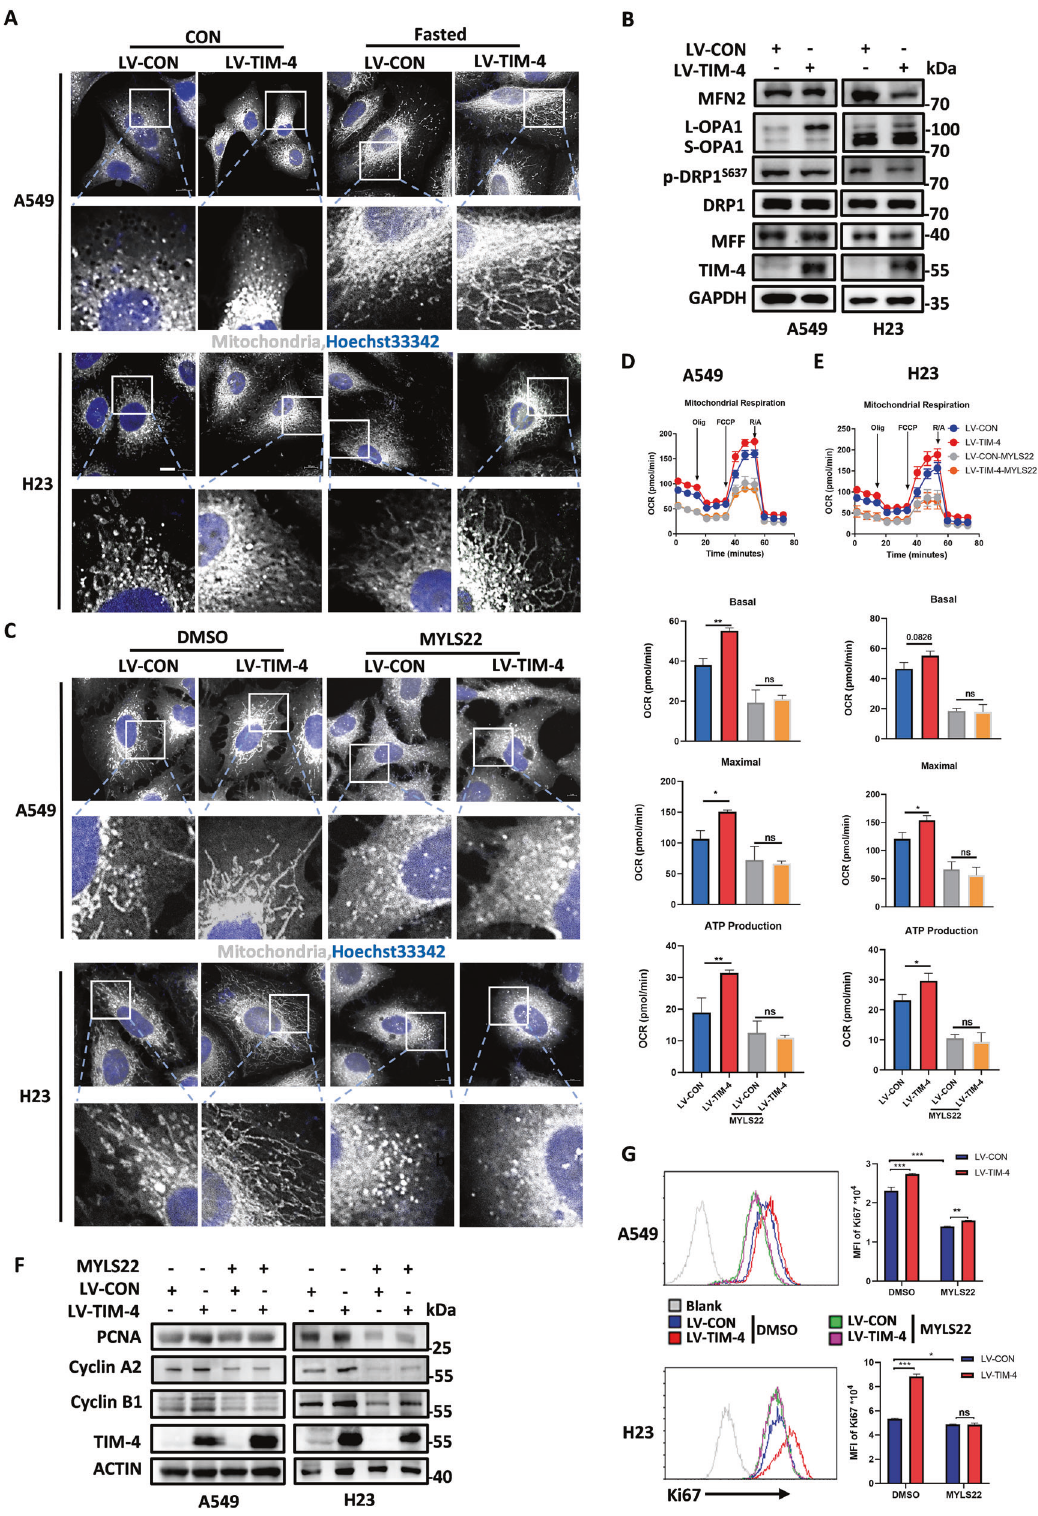
increased expression of PCNA and cell cycle molecules (Cyclin A2, Cyclin B1) (Fig. 3F), as well as Ki67 induced by TIM-4 (Fig. 3G). These fi ndings suggest that OPA1 is involved in TIM-4-promoted lung cancer progression.